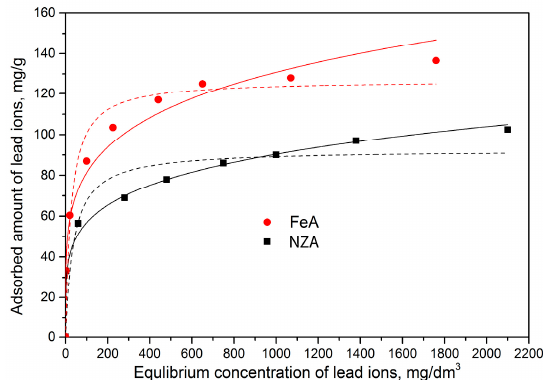
Figure 5. Pb 2+ adsorption isotherms for the NZA and FeA. Solid lines (Freundlich model) and dashed lines (Langmuir model).